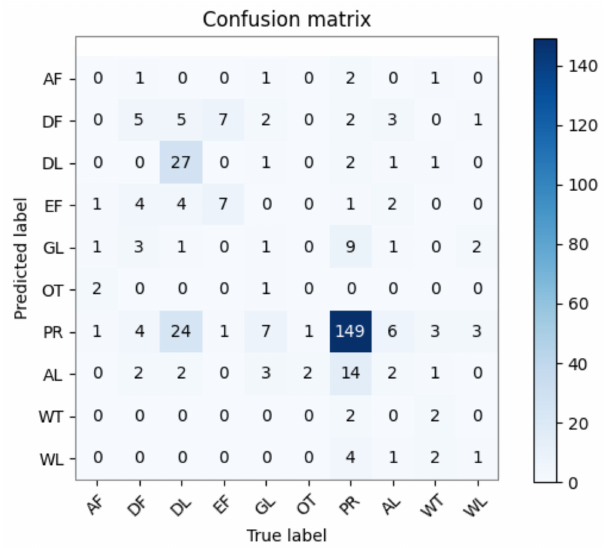
Figure 16. Visualized confusion matrix of PBF result in the Mun River